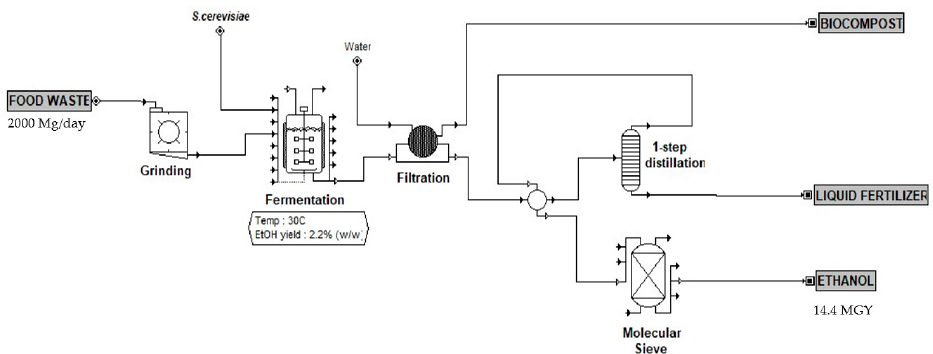
Figure 4. Process flow diagram of the scenario C FW fermentation process without enzymes and 1-step distillation